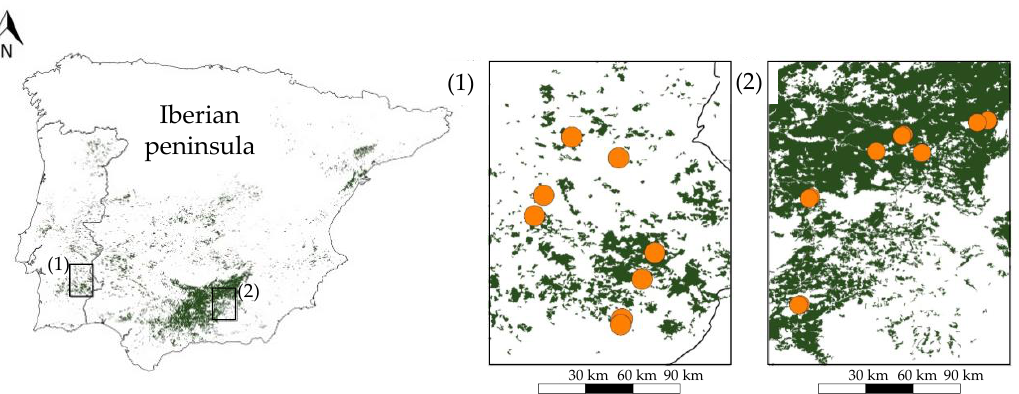
Figure 1. Location of the olive groves selected in this study. The green spots on the map correspond to the areas of land in Portugal (1) and Spain (2) used for olive cultivation. Orange circles indicate the location of the olive groves selected for the study. Table 1. Geographical location of the olive groves (IPM and organic management) considered in the south of Spain. The main characteristics of each of them (variety, area, age of the trees, plantation density) and the chemical control measures applied to control herbaceous plant cover, as well as against the carpophagous generation of P. oleae, are indicated.